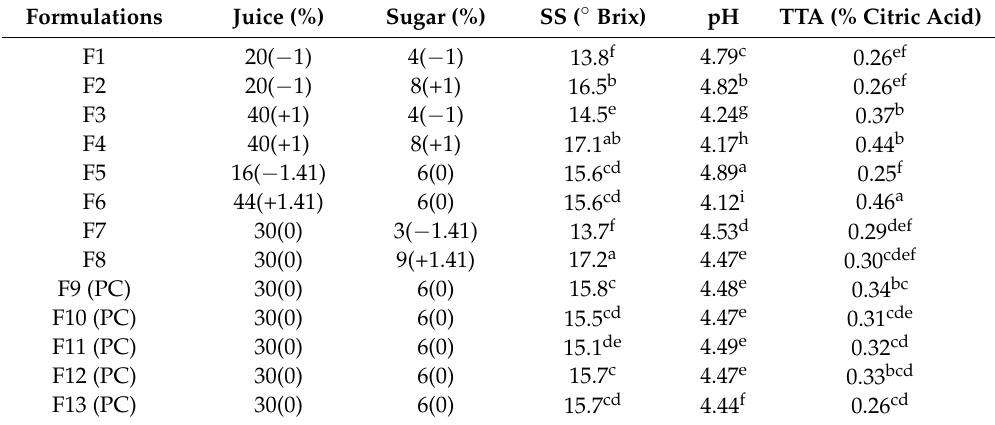
Table 3. Physicochemical analysis results for each